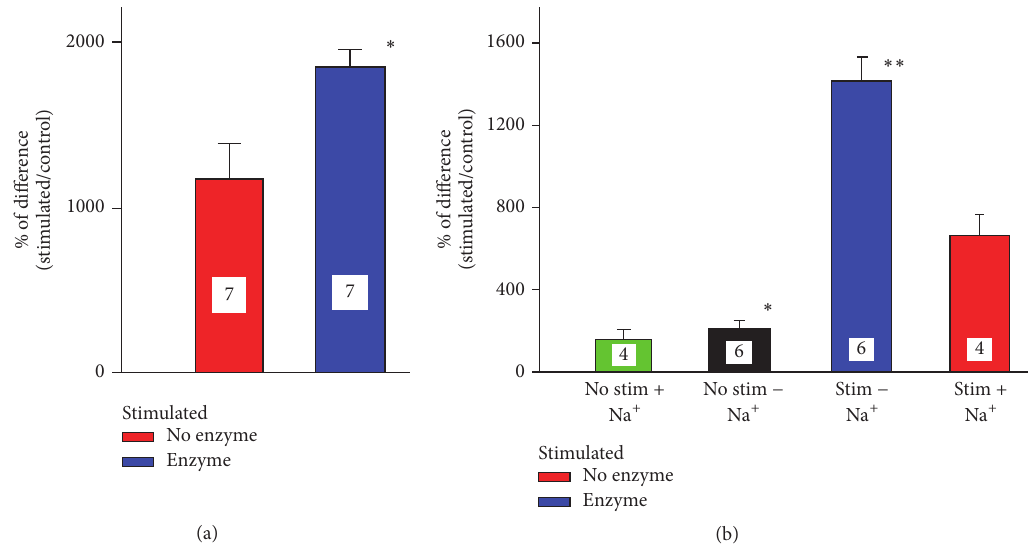
Figure 5: The modification of 45 Ca 2+ accumulation by synaptosomes either treated for 3 hrs with neuroaminidase (enzyme) or incubated in sodium-free Ringer’s solution. (a) Treatment of synaptosomes with neuroaminidase (0.2U/ml) significantly increased DC-evoked 45 Ca 2+ accumulation, as compared with nontreated ones and also by stimulated controls; ∗ 𝑝 < 0.006 , 𝑡 -test. (b) The omission of sodium ions from Ringer’s solution enhances 45 Ca 2+ accumulation in DC-stimulated and nonstimulated synaptosomes. The control, nonstimulated synaptosomes accumulated more 45 Ca 2+ in Na + -free Ringer’s solution (black bar), than in the presence of sodium (green bar); ∗ 𝑝 < 0.001 , ANOVA followed by Dunn’s test; ∗∗ 𝑝 < 0.001 . Stimulated synaptosomes accumulated less calcium in the presence of sodium (red bar), than in Na + -free solution (blue bar), 𝑝 < 0.029 , 𝑡